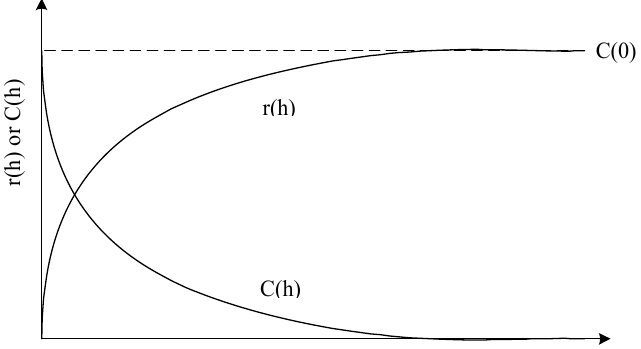
Figure 2. A diagram of the semivariogram r(h) and covariance function